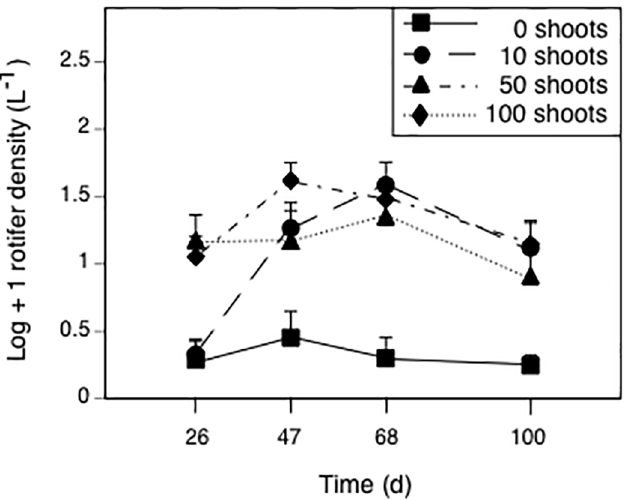
Fig 3. Effects of treatments planted with different initial numbers of Elodea shoots on rotifer density over time. Data are means + 1 SE.